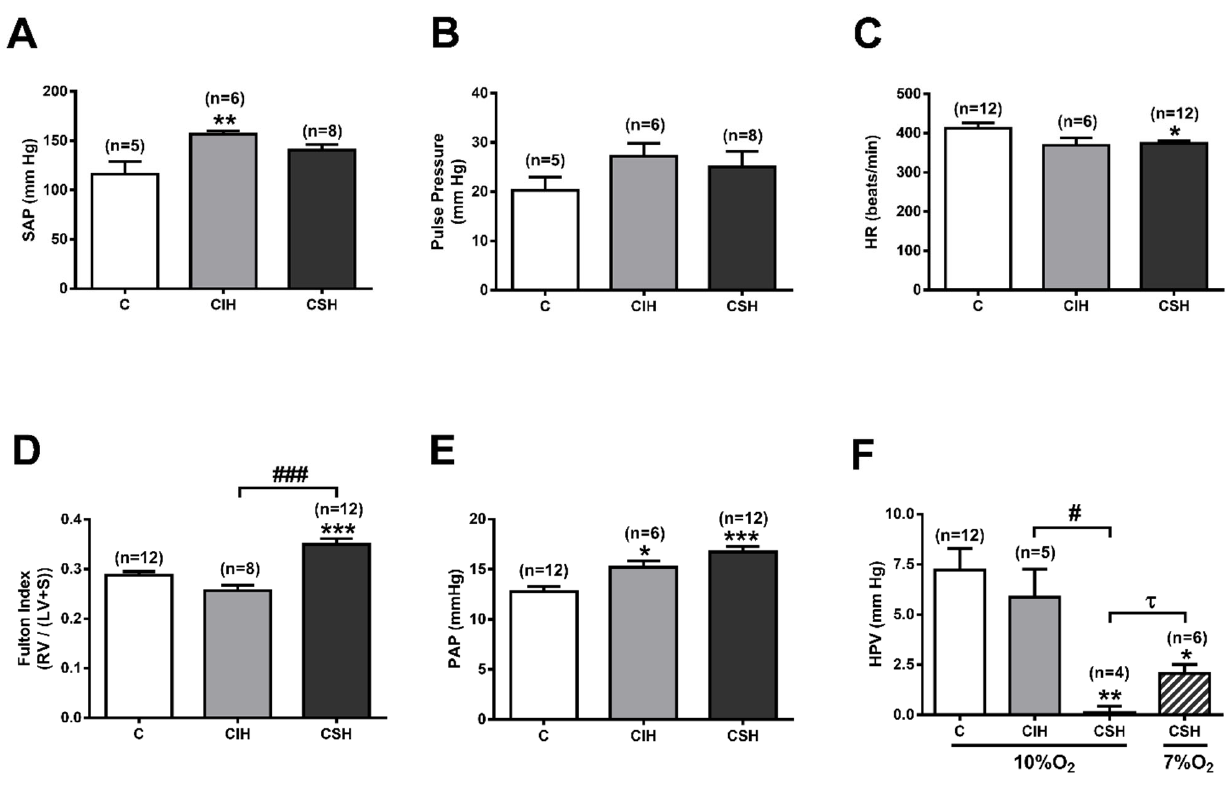
Figure 1. Hemodynamic measurements. ( A ) Mean systemic arterial pressure (SAP; mmHg) in C (control), CIH, and CSH animals. Data are expressed as mean ± SEM; ** p < 0.01, vs. C animals (one ‐ way ANOVA with Tukey´s multiple comparison test). ( B ) Pulse pressure (systolic minus diastolic pressure; mmHg) in C, CIH, and CSH animals. ( C ) Heart rate, as beats per minute, in C, CIH, and CSH animals; * p < 0.05 vs. C animals (one ‐ way ANOVA with Tukey´s multiple comparison test). ( D ) Fulton index (Right ventricle/ (Left ventricle + Septum)) in C, CIH, and CSH animals. Data are expressed as mean ± SEM; *** p < 0.001 vs. C animals (one ‐ way ANOVA with Tukey´s multiple comparison test); ### p < 0.001 CIH vs. CSH animals (unpaired t ‐ test). ( E ) Mean pulmonary arterial pressure (PAP; mmHg) in C, CIH, and CSH animals. Data are expressed as mean ± SEM; * p < 0.05, *** p < 0.001 vs. C animals (one ‐ way ANOVA with Tukey´s multiple comparison test); ( F ) Hypoxic pulmonary vasoconstriction response (HPV) to 10% O 2 in C, CIH, and CSH animals, and to 7% O 2 in CSH animals. Data expressed as mean ± SEM; * p < 0.05, ** p < 0.01 vs. C animals (one ‐ way ANOVA with Tukey´s multiple comparison test); # p < 0.05 CIH vs. CSH animals (unpaired t ‐ test); τ p < 0.05 CSH 10% O 2 vs. CSH 7% O 2 (unpaired t ‐ test).